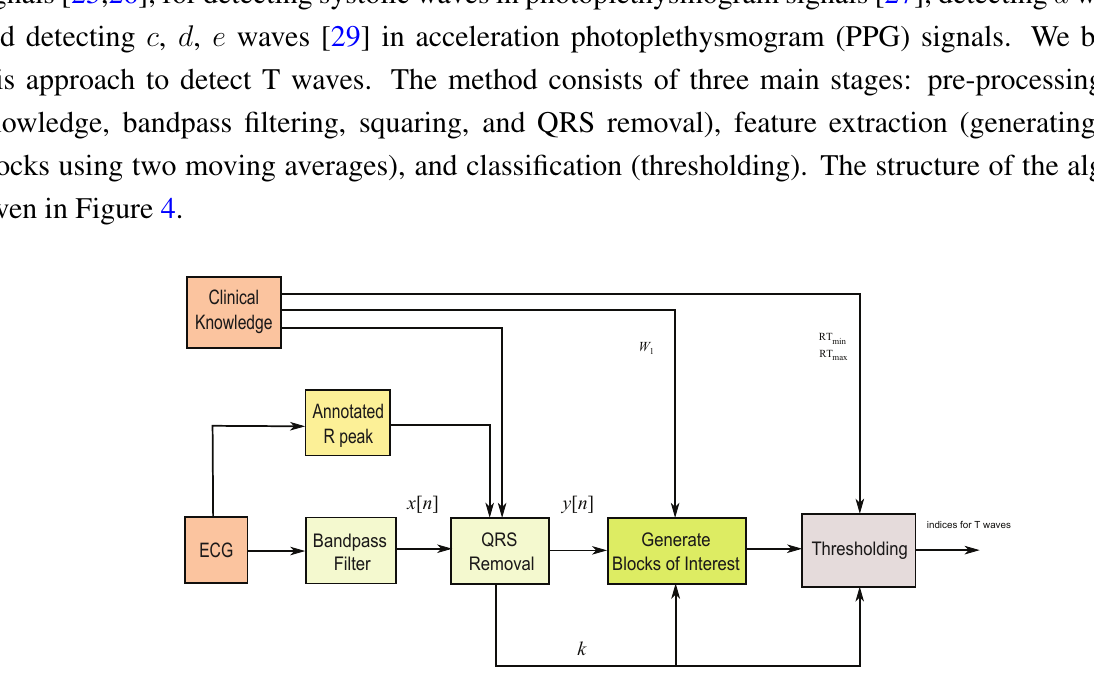
Figure 4. Structure of the T waves detection algorithm. The algorithm consists of three main stages: pre-processing (clinical knowledge, bandpass filtering, squaring, and QRS removal), feature extraction (generating potential blocks using two moving averages), and classification